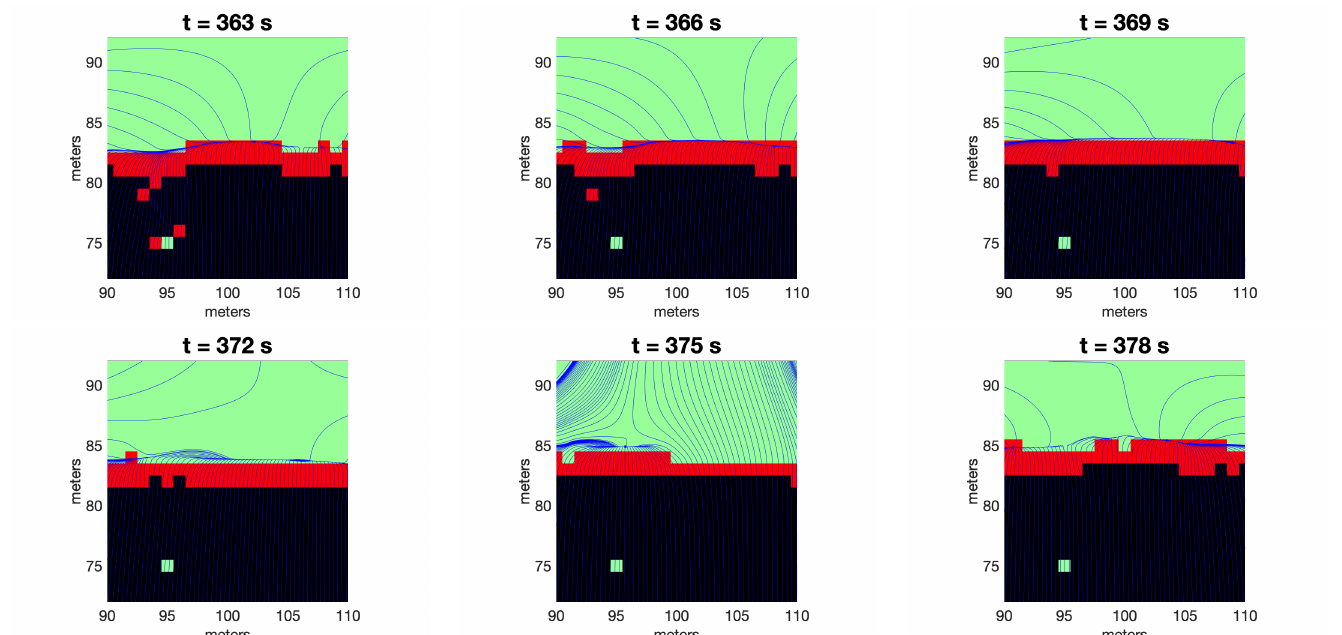
Figure 5. A configuration resulting in a slow rate of spread of 0.12 m/s. As the fire line is several meters wide, the convective sink does not allow the fire to propagate forward until cells have extinguished.